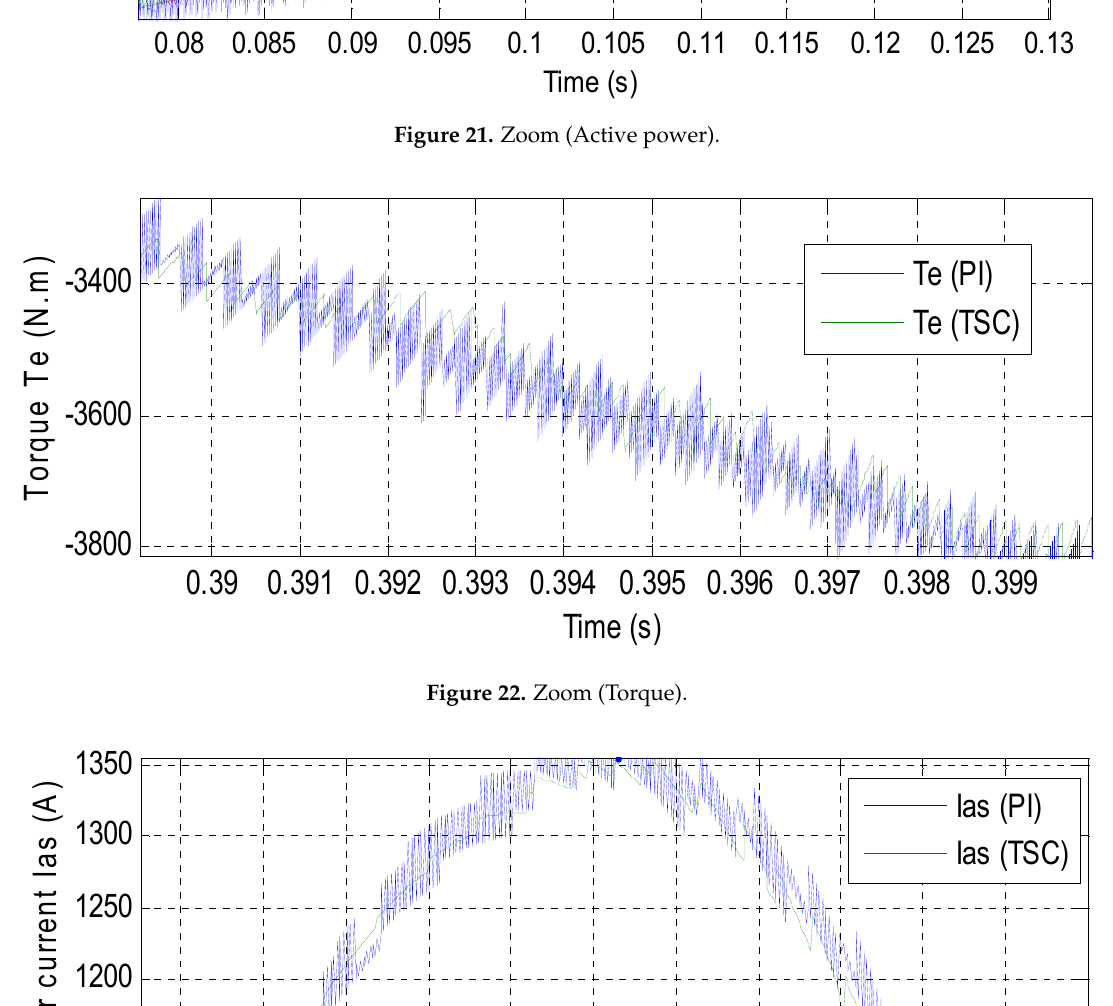
Figure 21. Zoom ( Active power). Figure 21. Zoom (Active power).